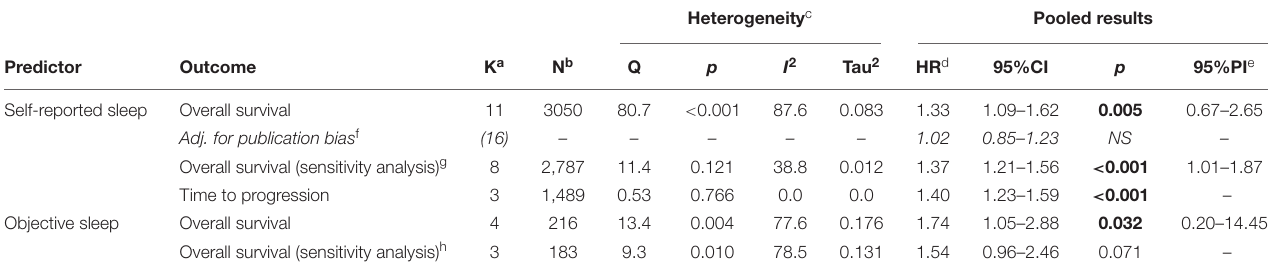
TABLE 2 | Meta-analysis of associations between poorer self-reported sleep and overall survival and time to progression, and between poorer objective sleep and overall survival.